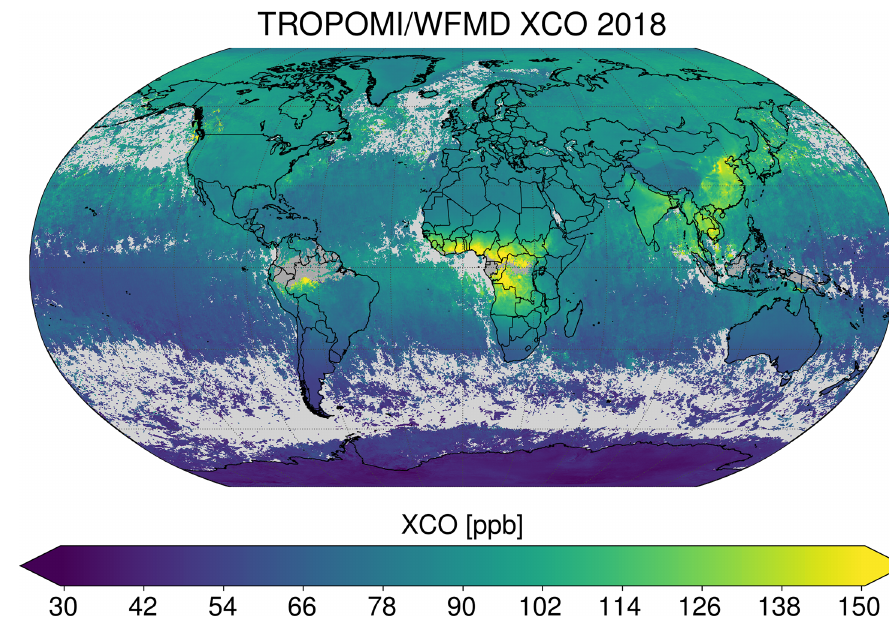
Figure 13. Global yearly average of TROPOMI/WFMD XCO for 2018.